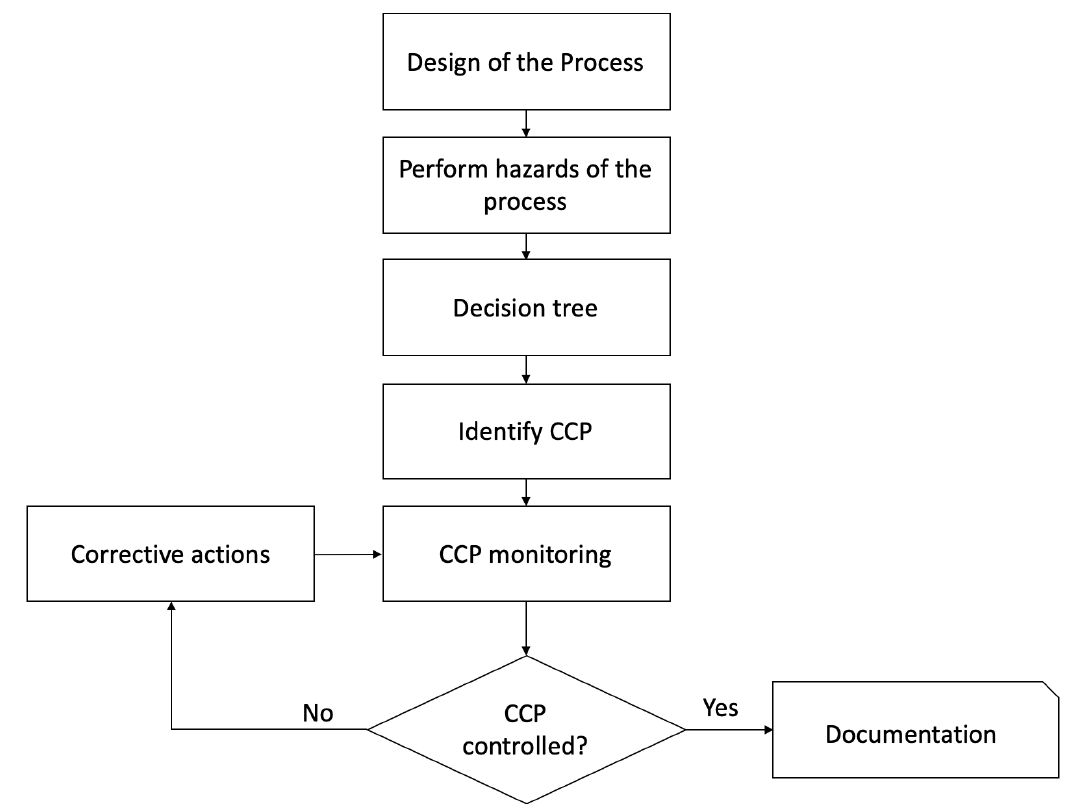
FIGURE 1 - Schematic representation of the main steps of the HACCP procedure for a pharmaceutical plant